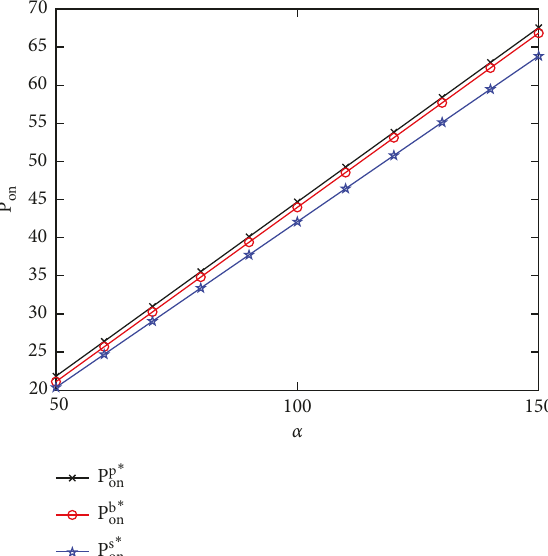
Figure 7: Impact of change in α on online price.